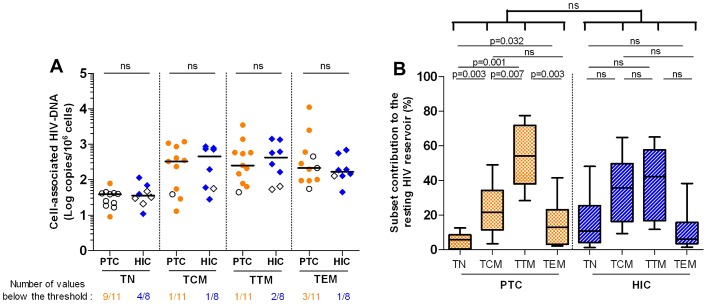
Weak contribution of long-lived resting CD4+ T cells to the HIV reservoir in the post-treatment controllers.
A. HIV infection levels in the resting TN, TCM, TTM and TEM cells of 11 PTCs and 8 HICs. The results are expressed as the log10 HIV DNA copy numbers per million cells, and the medians are represented. The open symbols are values below the threshold of detection. ‘ns’ are non significant p values. B. CD4+ T cell subsets contribution to the resting HIV reservoir, considering both infection levels and frequency. The results are expressed as the median percentage of the resting CD4 HIV reservoir, with interquartile range [25%–75%] and minimum and maximum values. Statistical analyses were applied between all subsets from a single group as well as between each subset from the two groups.